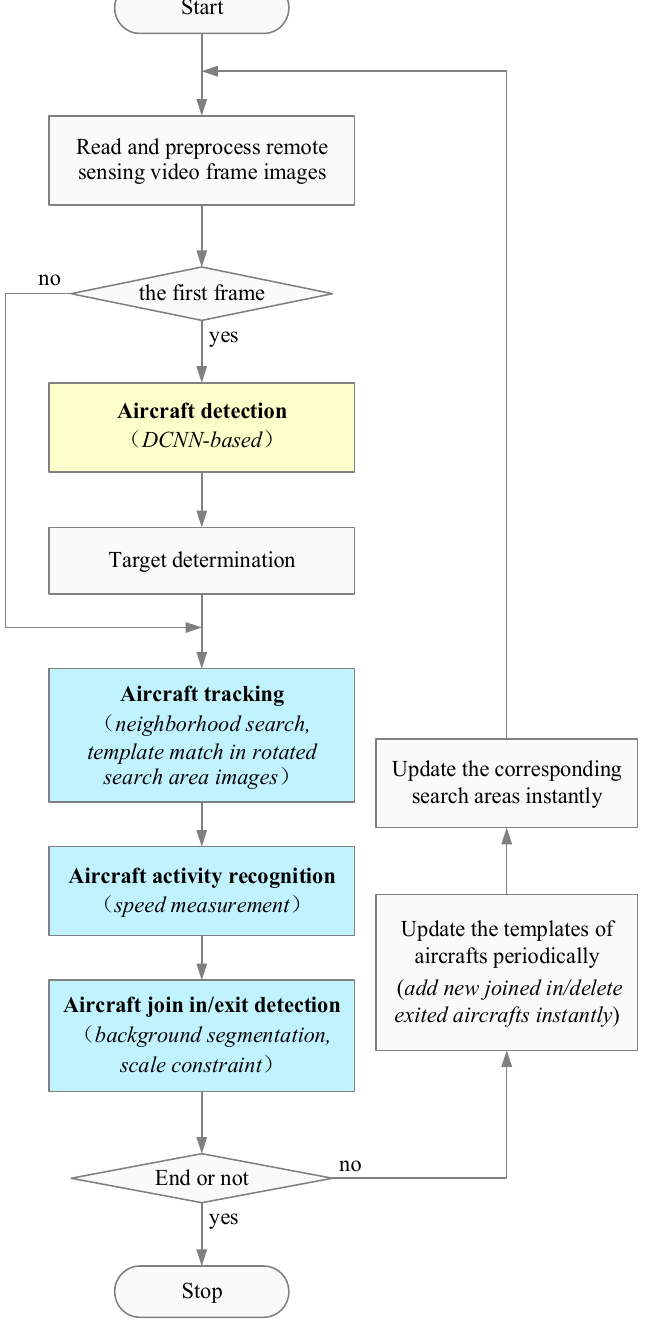
Figure 2. Flow chart of the algorithm.